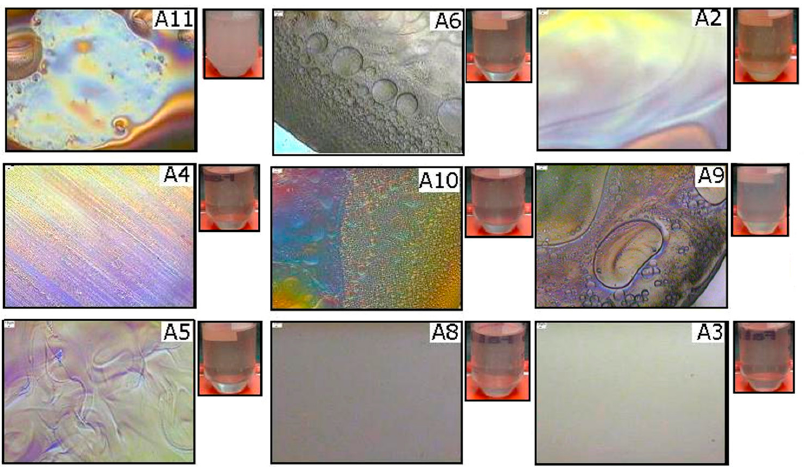
Figure 4. Optical microscope images, with crossed polarizers at 5 × magnification, of the ME corresponding to the OP//AG54//AP system at T = 25 °C.